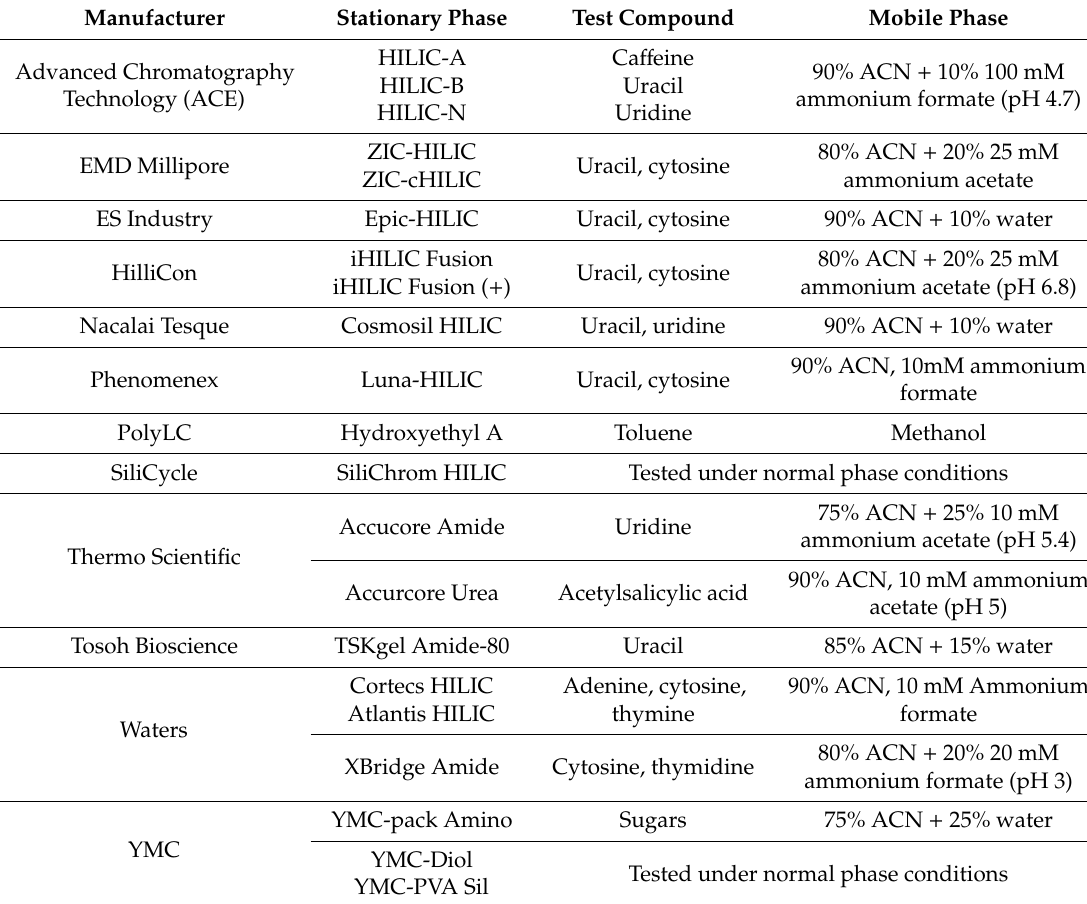
Table 1. Survey of testing procedures of hydrophilic interaction chromatography (HILIC) column